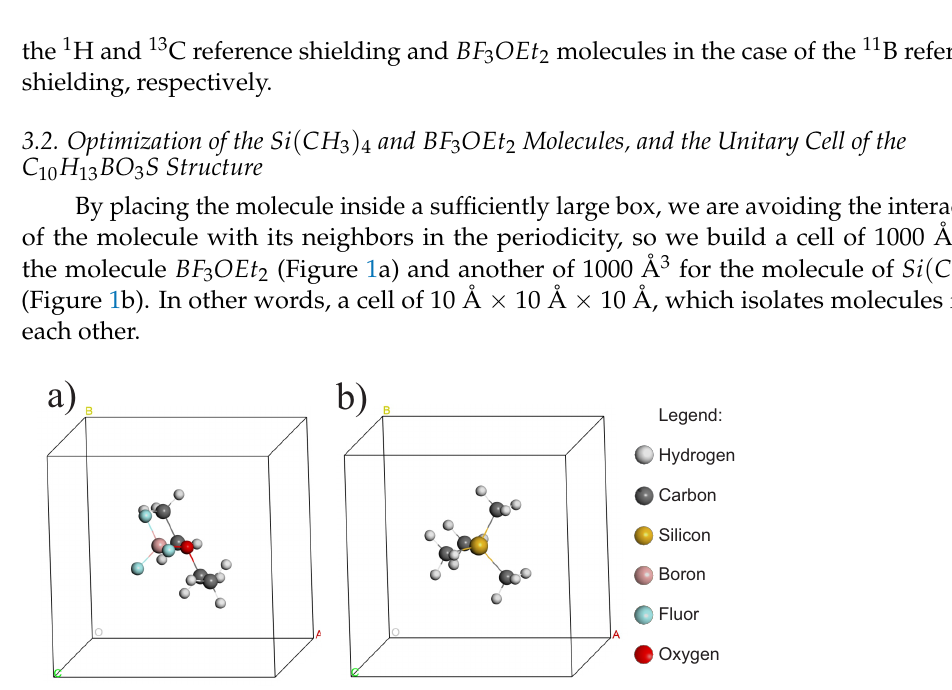
Figure 1. ( a ) 1000 Å 3 cell for the BF 3 OEt 2 molecule. ( b ) 1000 Å 3 cell for the Si ( CH 3 ) 4 molecule. The legend applies to both